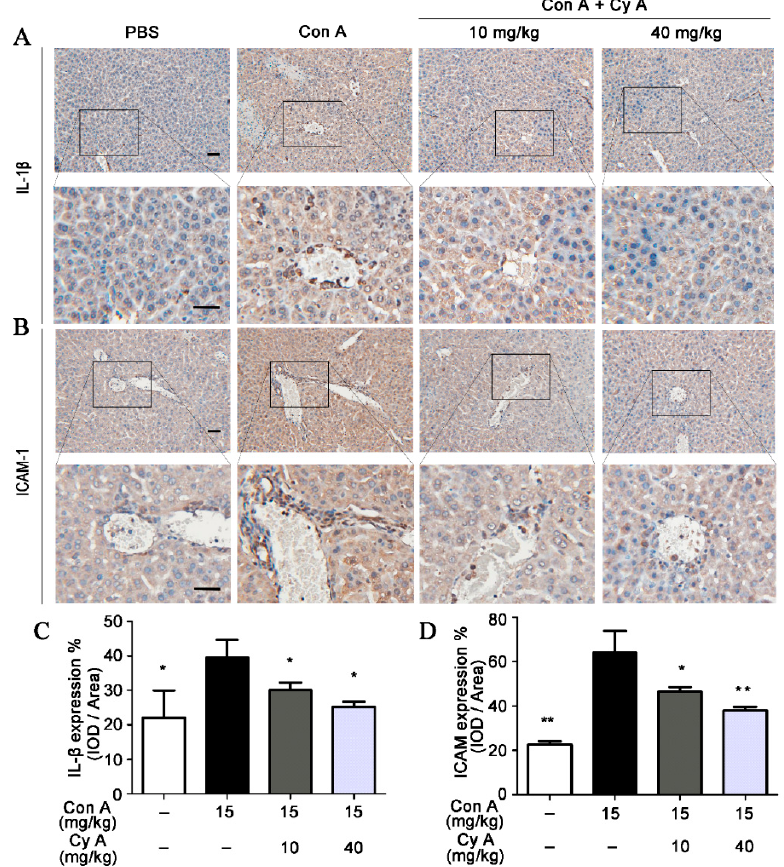
Figure 3. CyA attenuated the expression of IL-1 β and ICAM-1 in the liver of Con A-injured mice. Mice were treated in the same way as described in Figure 1. The liver was removed and sectioned, and the expressions of IL-1 β and ICAM-1 were stained with anti-IL-1 β and anti-ICAM-1 antibodies and assessed by IOD method. The results shown in ( A , B ) are representative immunohistochemical pictures for IL-1